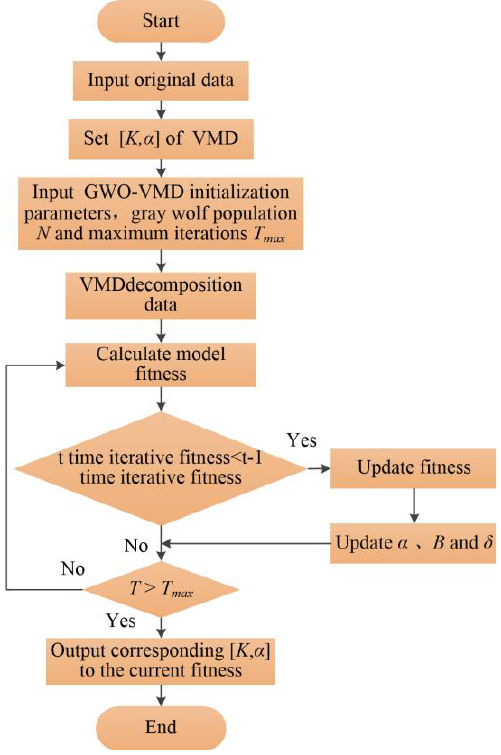
Figure 4. GWO − VMD time series decomposition method.